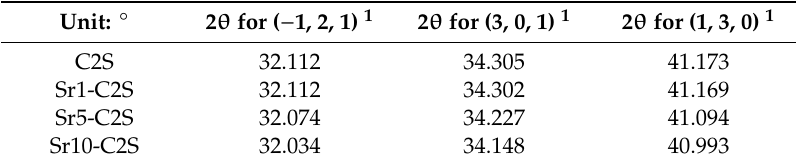
Table 3. 2 θ (deg.) values for ( − 1, 2, 1), (3, 0, 1) and (1, 3, 0) crystallographic plane of C2S and Sr-C2S.